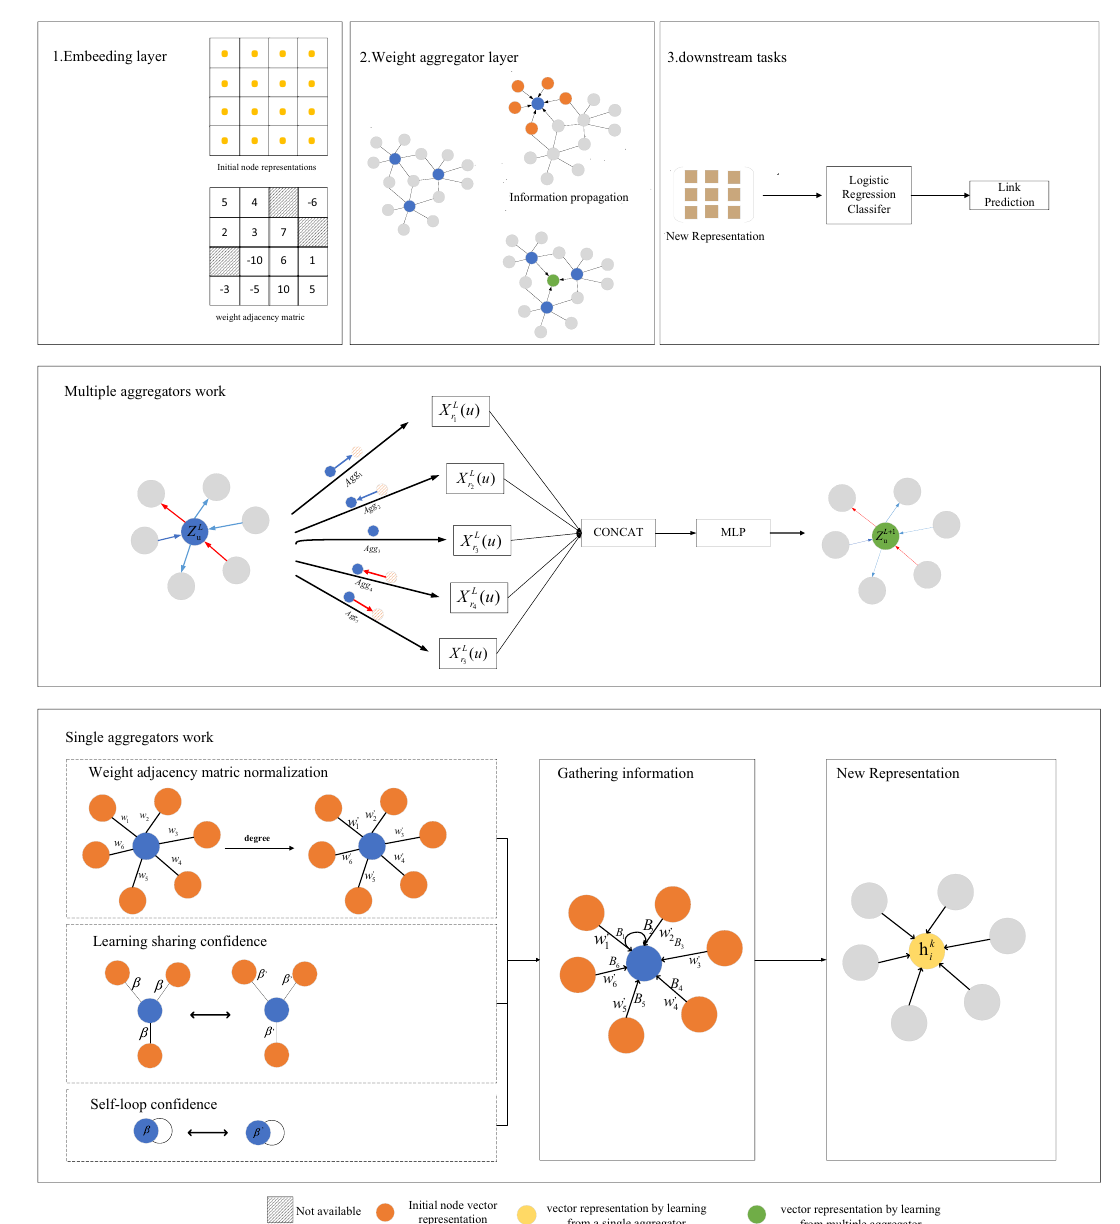
Fig. 4 The weighted GNN algorithm of WSNN. Embedding layer: initializes the node vector and the production weight adjacency matrix; weight aggregator layer: used to propagate and aggregate